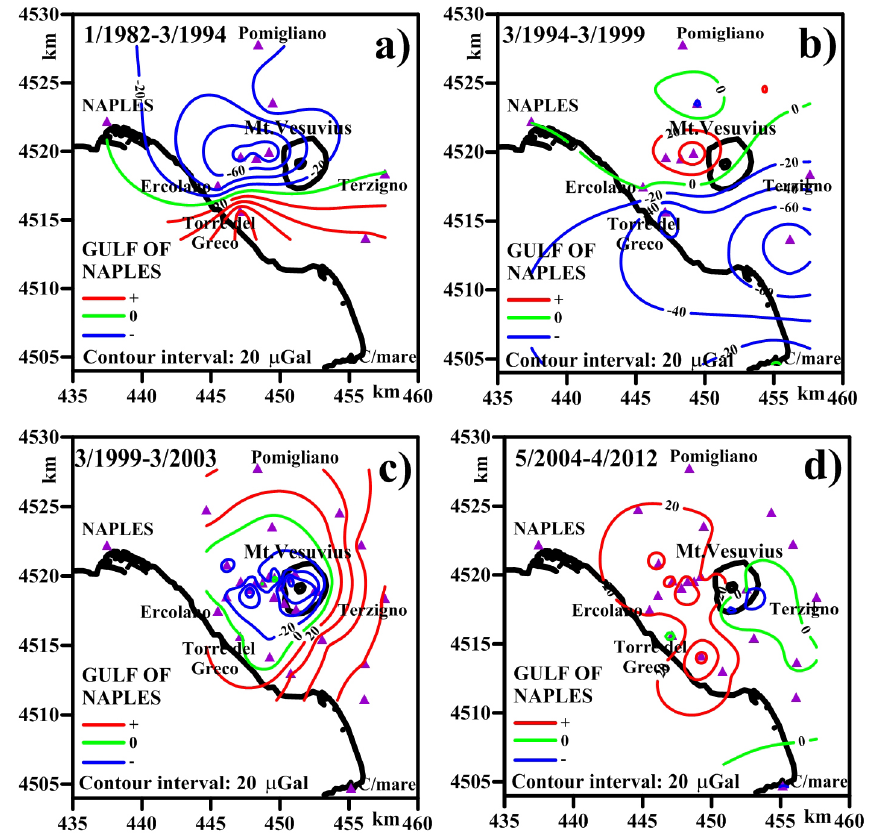
Figure 3. Gravity change fields over the recognized long-term periods characterized by significant gravity changes: a) 1/1982-3/1994; b) 3/1994 – 3/1999; c) 3/1999 – 3/2003; d) 5/2004 to present days. Red contour lines indicate gravity increase, blue lines gravity decrease and green lines the areas of null gravity